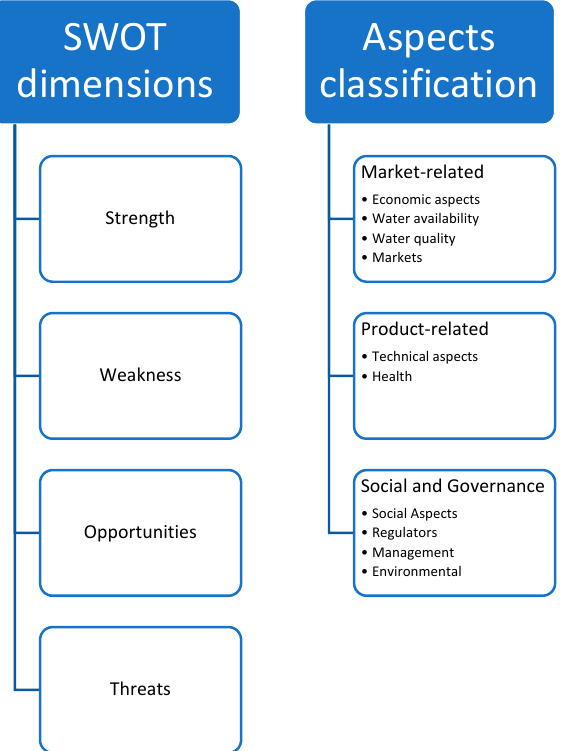
Figure 1. SWOT analysis dimensions and aspects classification proposed.